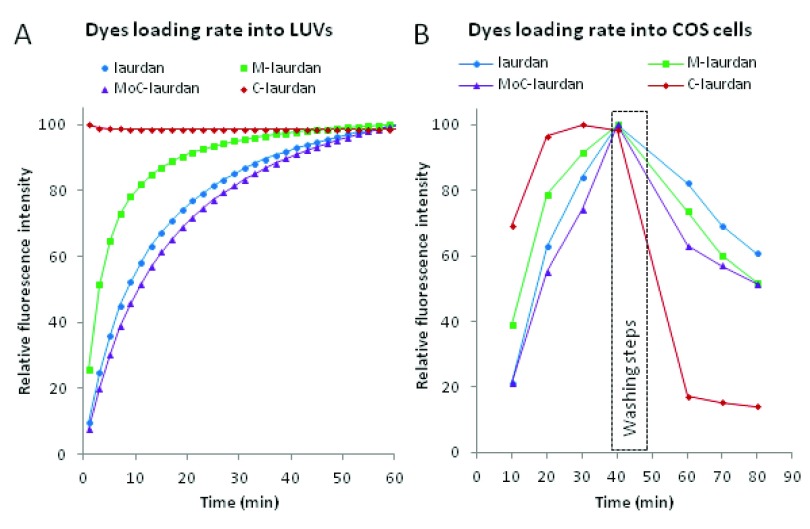
Time dependence of dyes incorporation into LUVs and COS7 cells.
A (Left panel): Incorporation of the dyes into LUVs resulted in an increase of the fluorescence intensity over time. Unlabeled LUVs made of DPPC/chol (6:4) (100 µM, sample volume 3 ml) were mixed with dyes dissolved in DMSO. The final dye concentrations were 1 µM and the DMSO/water ratio 1:1000. Measurements were carried out at 20°C and fluorescence intensities were recorded at 440 nm. The fitting curve was obtained using a one site binding equation.
B (Right panel): For flow cytometry (FACS), cells were harvested as a single cell suspension in tissue culture medium + serum after trypsinization and washed twice with PBS with no serum. For each probe, 1 µl of stock solution at 2 mM in DMSO was mixed with 2 million cells in 200 µl PBS (10 µM final) at room temperature. After 10 minutes, the tubes were placed in a water bath at 37°C for 30 min, before cells were washed twice in 5 ml and resuspended in a final volume of 1 ml with PBS + 10% serum warmed to 37°C. Cells were then further incubated for 20 min at 37°C. Every 10 minutes throughout the procedure, the volume corresponding to 250.000 cells was taken from each sample, placed on ice in a final volume of 500 µl ice-cold PBS + 10% serum, and submitted to FACS analysis on a LSR II flow cytometer with a UV laser and using the channel with a 450/50 BP filter.